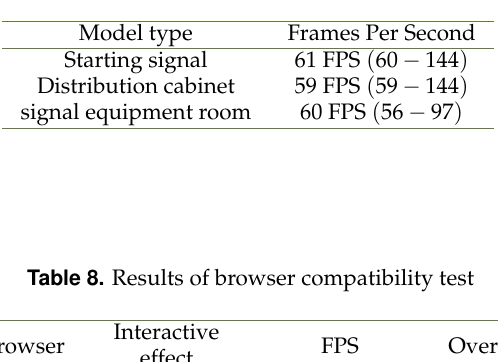
Table 7. Comparison of model rendering frame rate